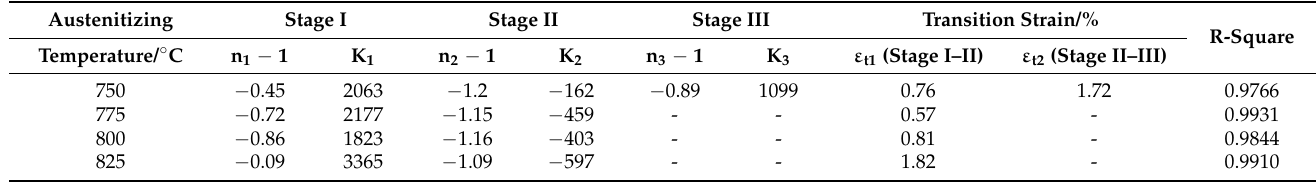
Table 3. Parameters related to the work-hardening behavior in the D C-J model of LH800